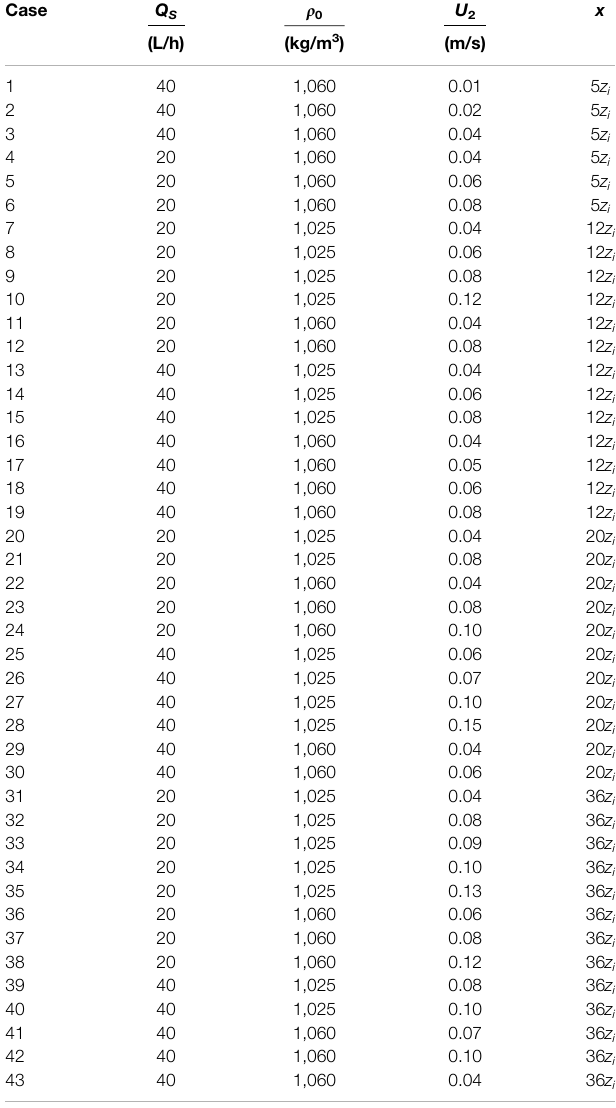
TABLE 1 | Experimental cases and the associated parameter